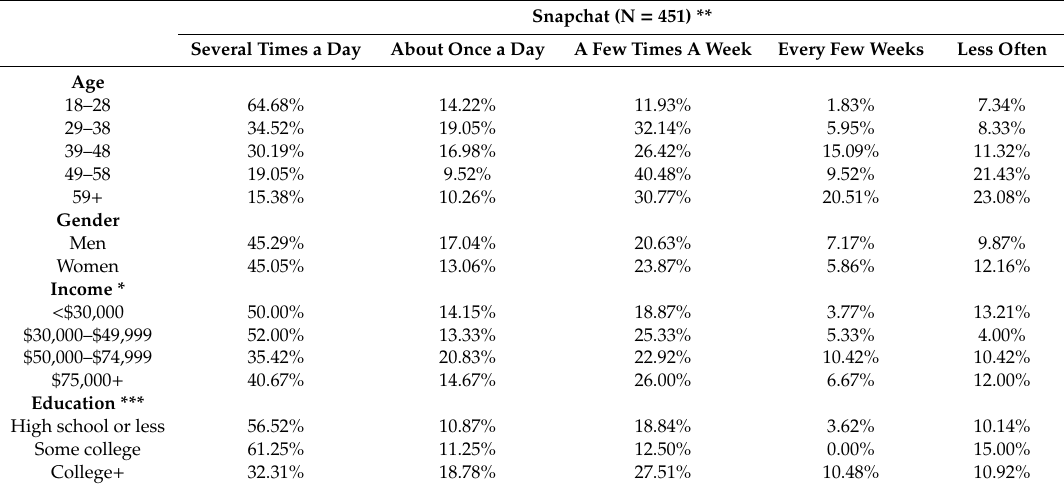
Table A4. Overview of Snapchat users (own